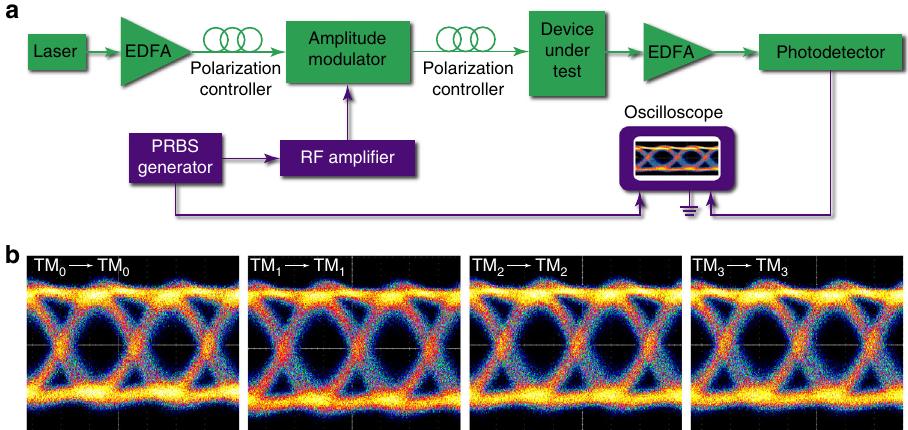
Fig. 7 Experimental demonstration of high-dimensional data transmission with BICs. a Experimental setup for measuring data transmission. EDFA: erbium-doped fi ber ampli fi er; PRBS generator: pseudorandom binary sequence generator. b Measured eye diagrams of data transmission through a four- channel mode (de)multiplexer at 40